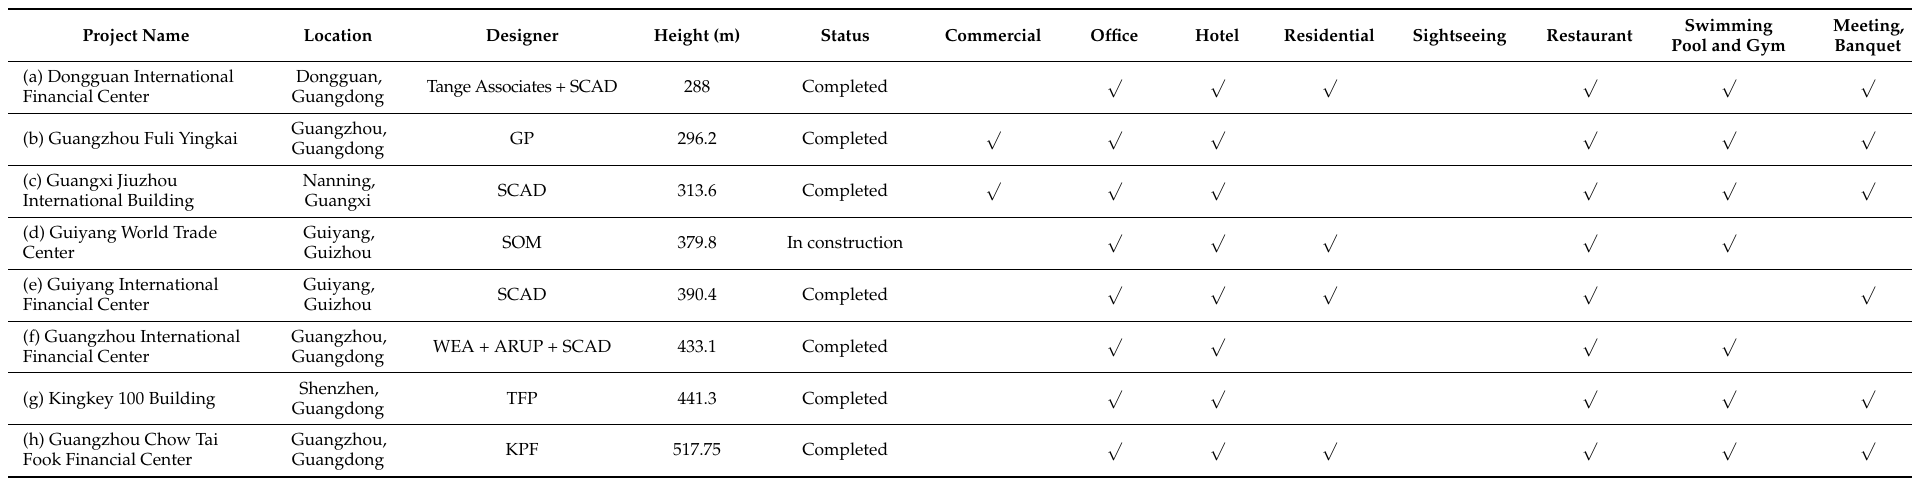
Table 4. Building height and business combination mode of the eight high-rise